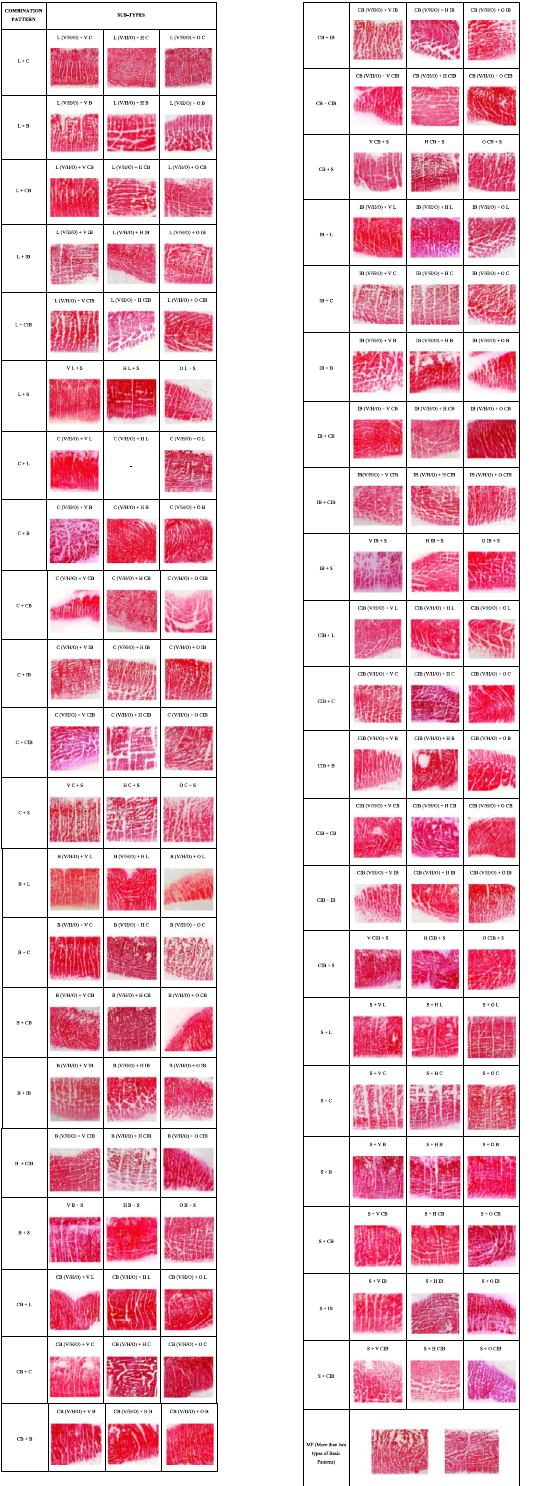
Table 3 Various types of Combination Patterns and their subtypes along with macro